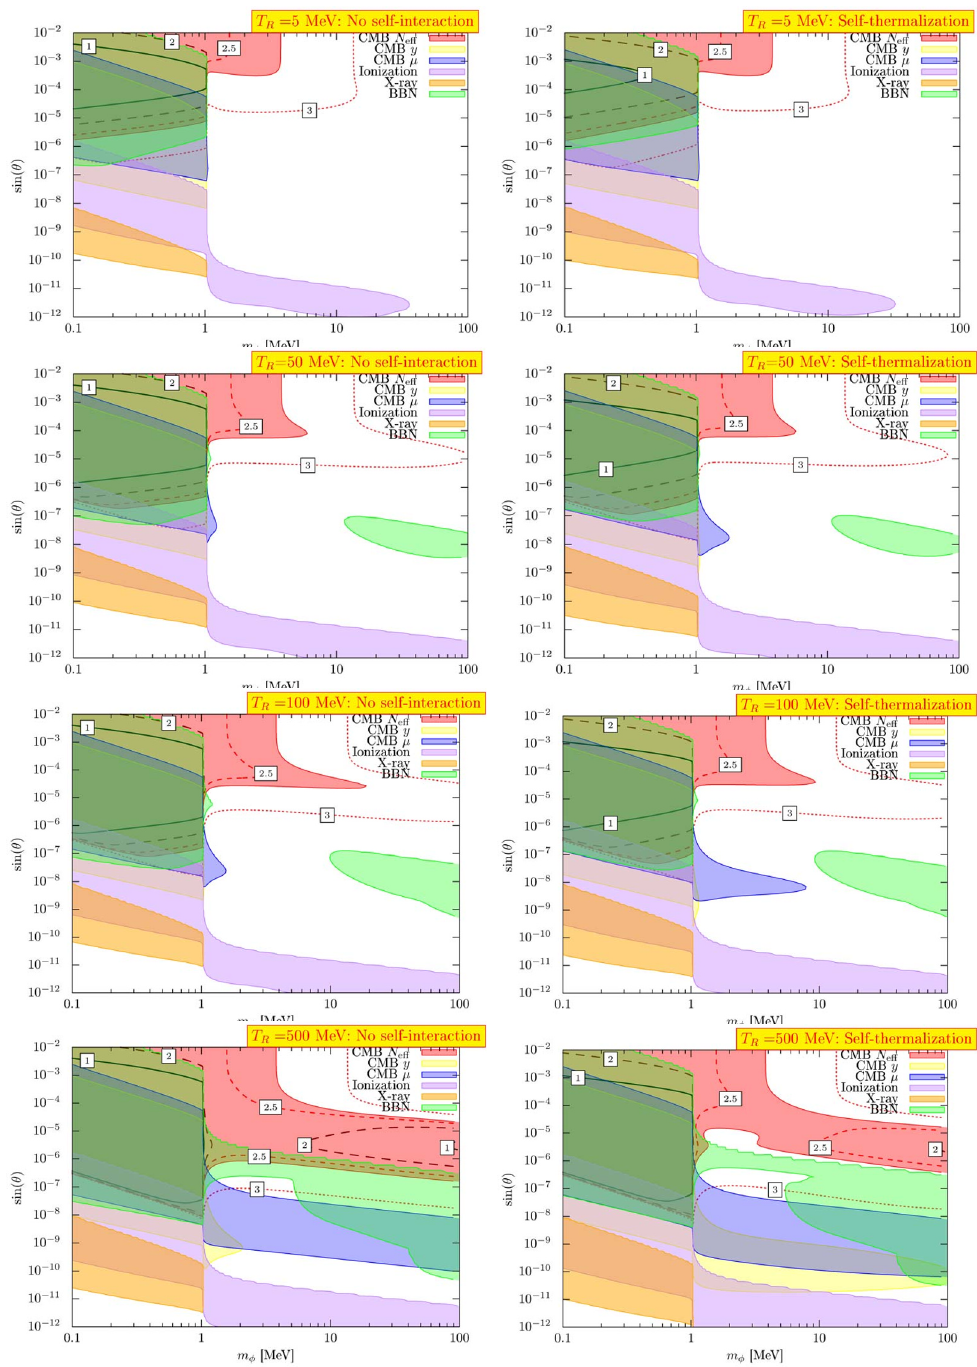
Figure 17. Cosmological constraints on the dark scalar for different reheating temperatures.